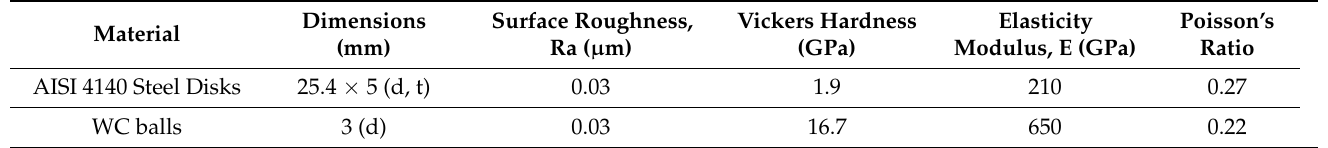
Table 1. Characteristics and properties of the materials for tribological tests. Material